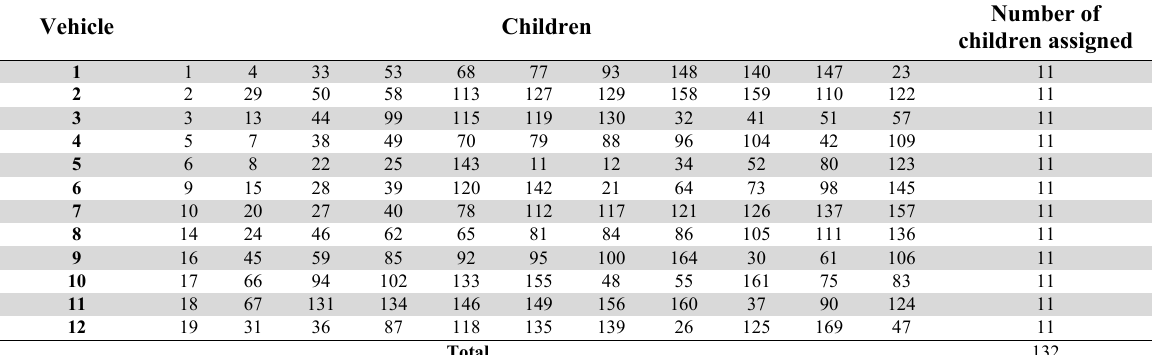
Assignment of children to vehicles by the group technology algorithm Vehicle